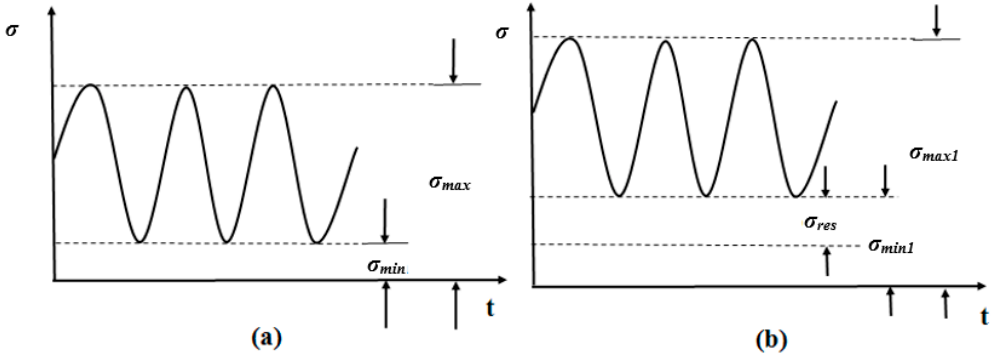
Figure 11. The fatigue cyclic stress: ( a ) without res